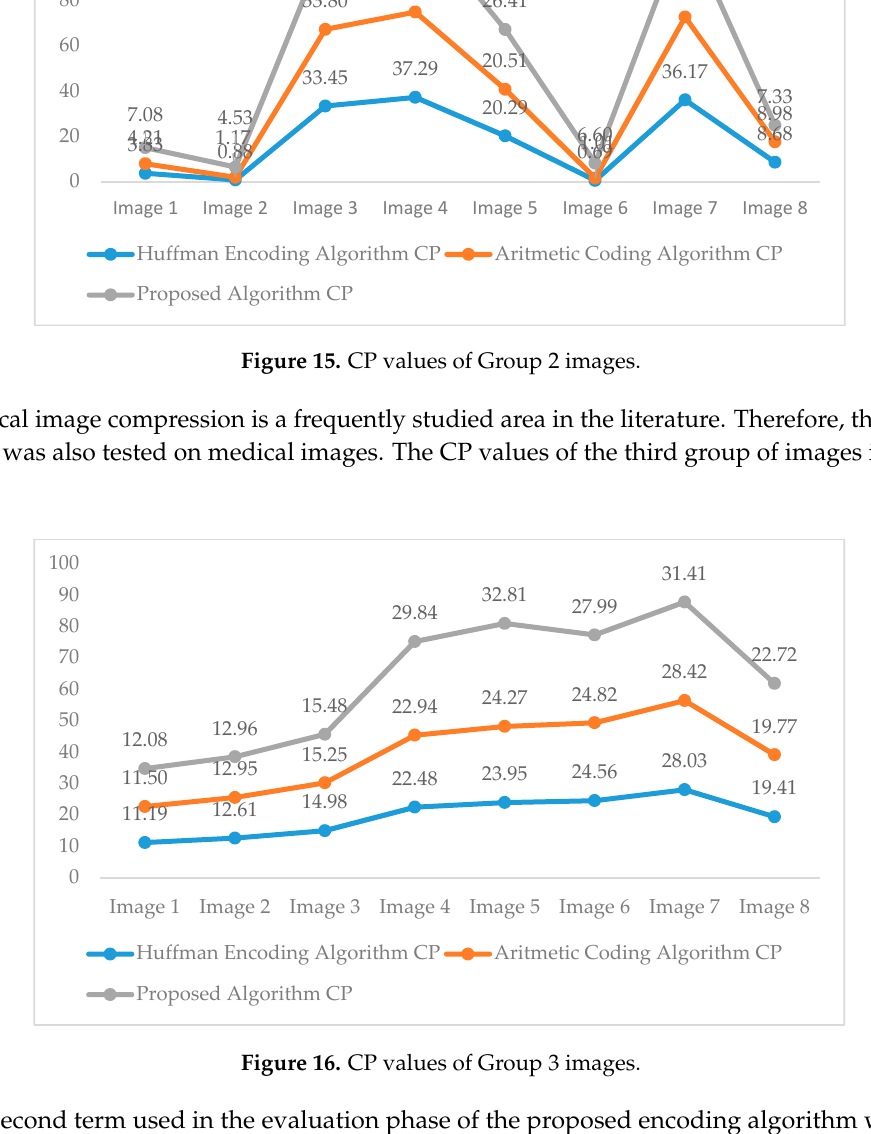
Figure 14. Compression percentage (CP) values of Group 1 images.